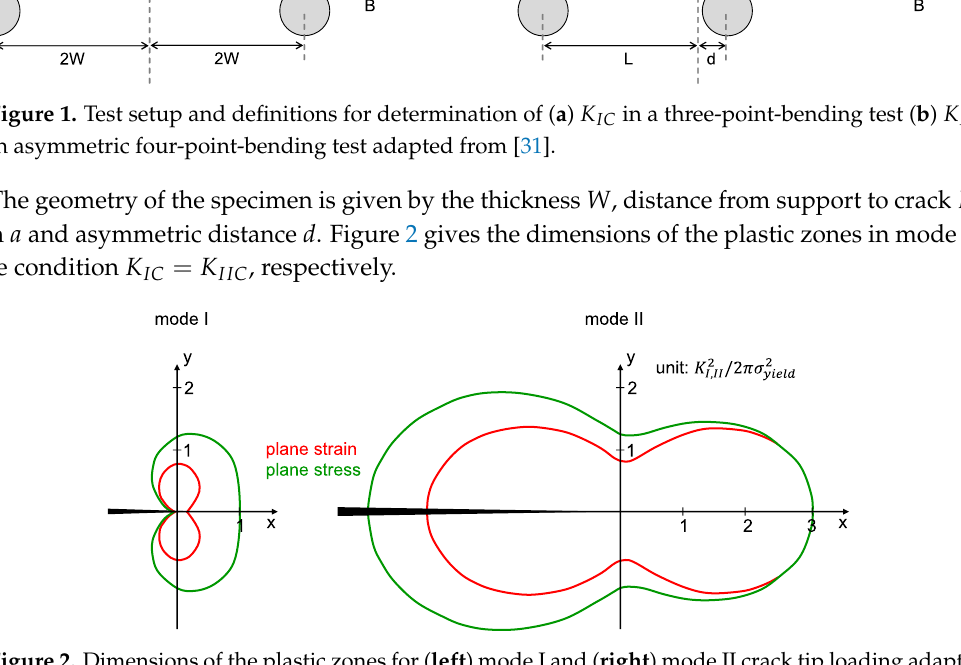
Figure 2. Dimensions of the plastic zones for ( left ) mode I and ( right ) mode II crack tip loading adapted from